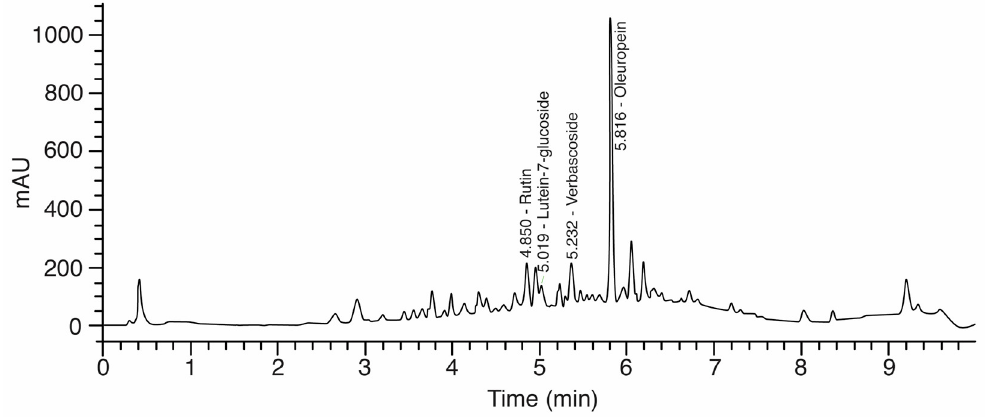
Figure 6. A typical chromatogram of individual polyphenol composition in olive leaf extracts.